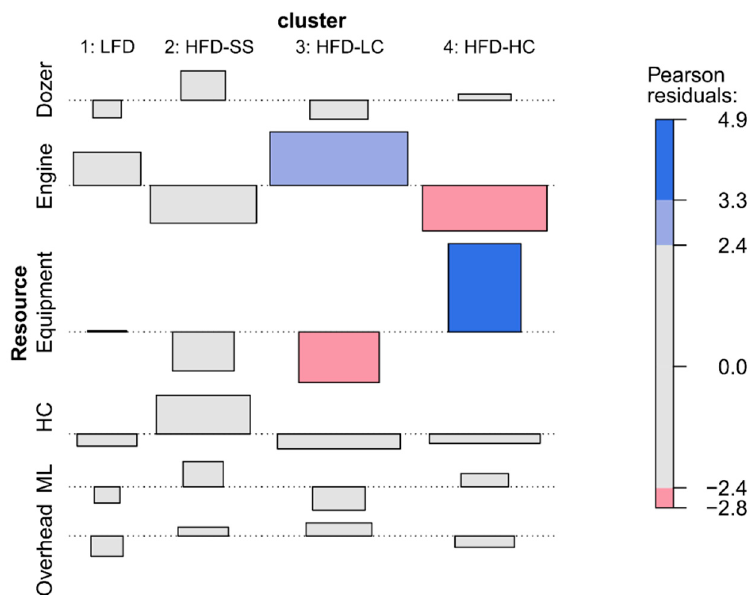
Figure 7. Locations of 166 US wildland firefighter entrapments (1981–2017) by cluster type and Geographic Area Coordination Center (GACC). The abbreviated GACCs include the Northwest (NW), North Ops (NOps), and South Ops (SOps).